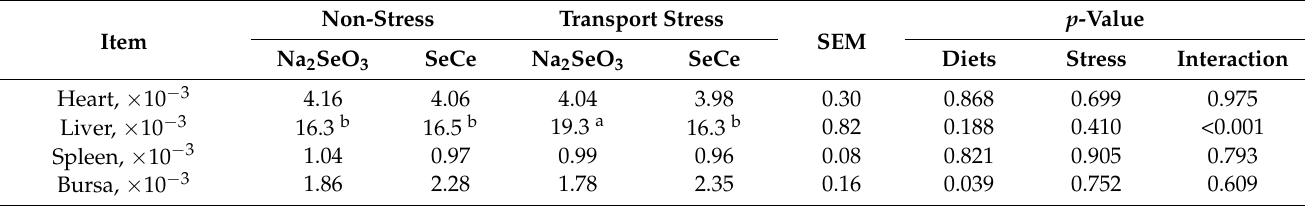
Table 2. Effects of dietary Se-enriched Cardamine enshiensis supplementation on relative organ weight of broilers under transport stress 1